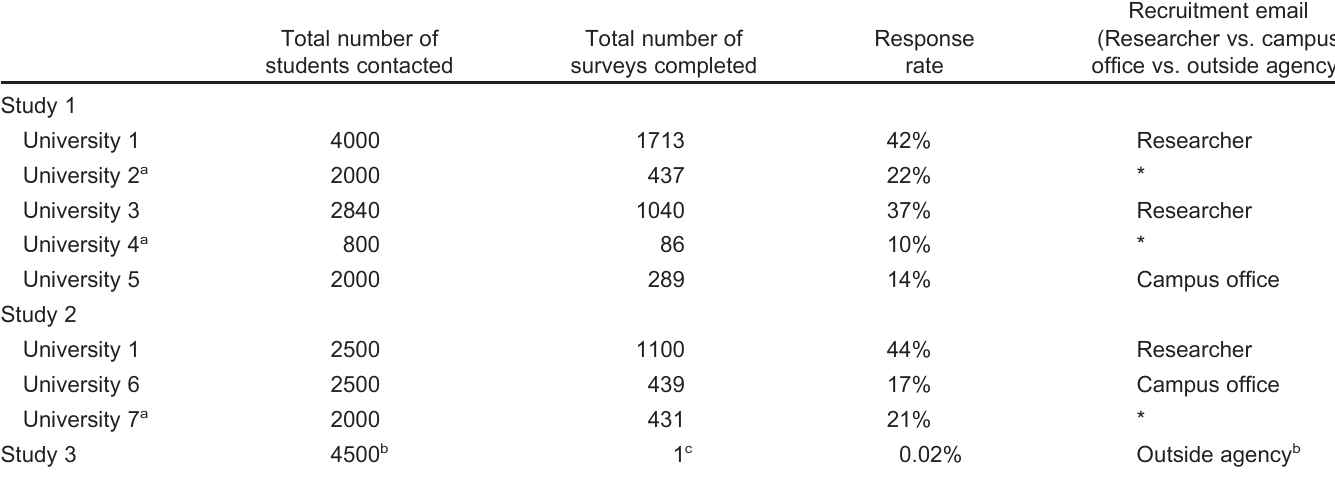
Table 2. Response rate of universities.